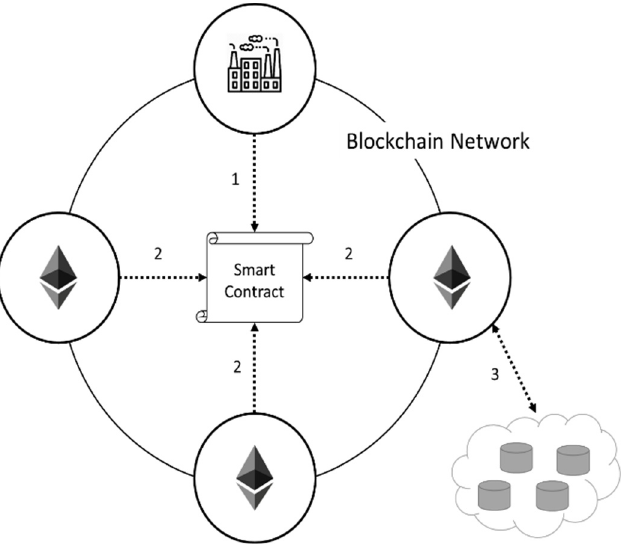
Figure 4. Firmware update file transmission.